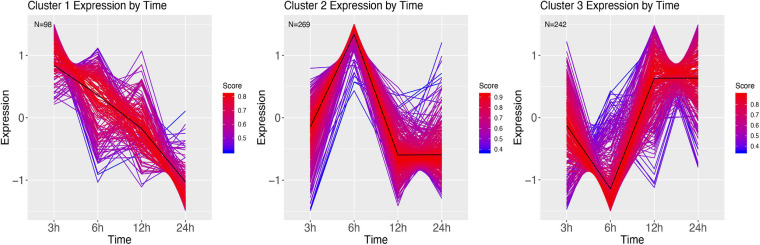
DEG clusters of larvae injected with PBS over 24 h. Color indicates cluster membership score, ranging from 0 (blue) to 1 (red). Numbers in each graph represent the number of genes in this cluster with a membership value higher than 0.6.